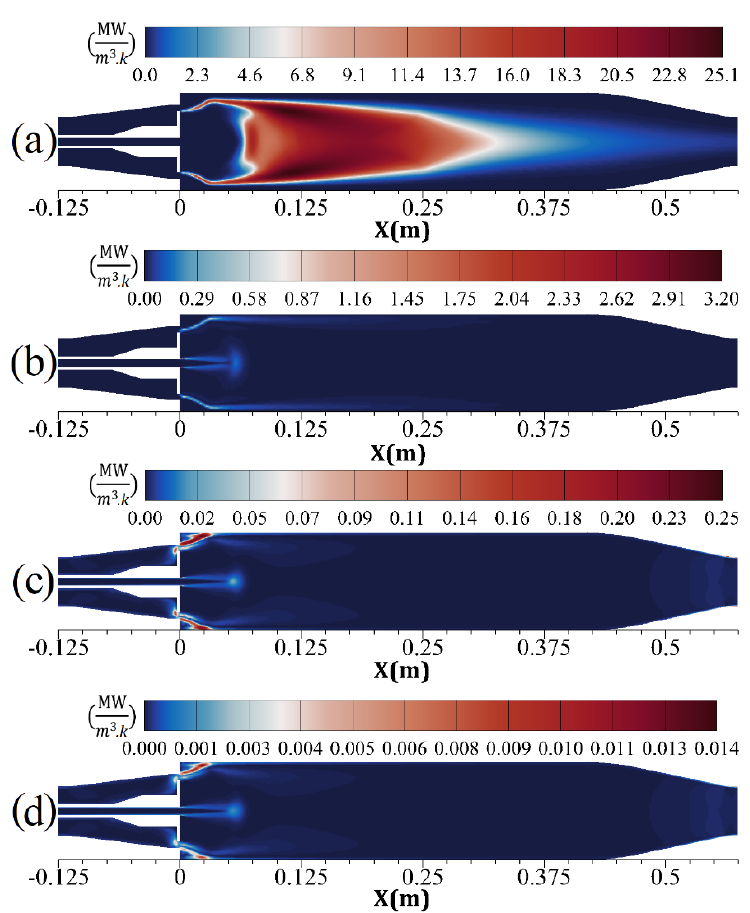
Figure 10. Generation rate of entropy owing to ( a ) chemical reactions, ( b ) heat conduction, ( c ) mass diffusion and ( d ) viscous dissipation along mid-plane (Z = 0).